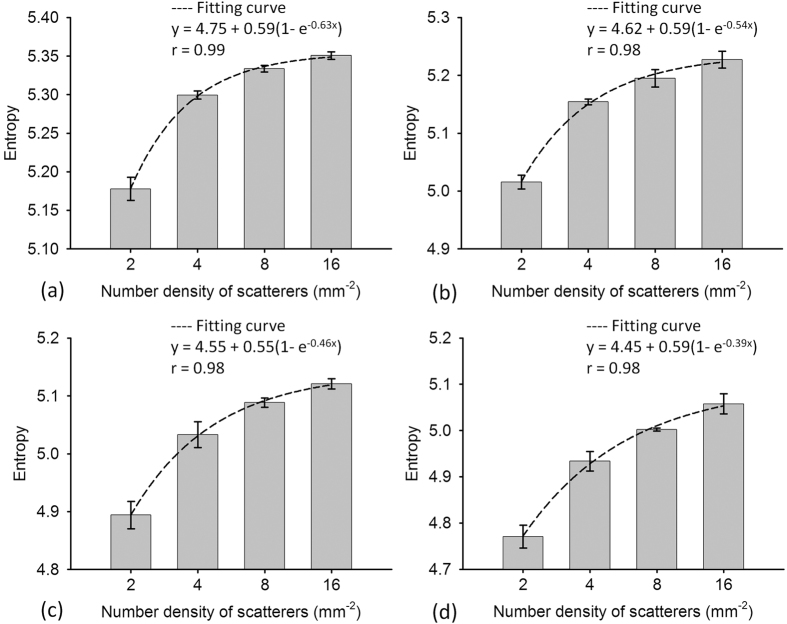
Simulated entropy as a function of the number density of the scatterers obtained at different SLs.(a) SL = 1; (b) SL = 2; (c) SL = 3; (d) SL = 4. Entropy images constructed using windows of different sizes can detect the variation in the number density of scatterers in a homogeneous medium. Data were expressed by mean ± standard deviation.